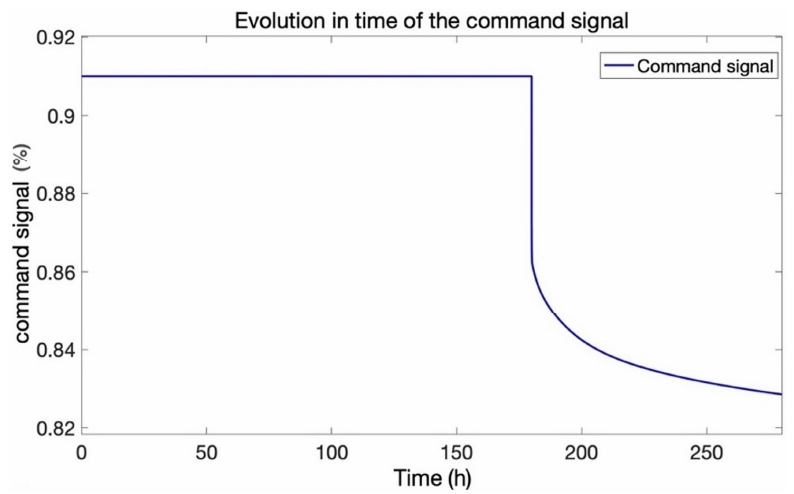
Figure 20. Evolution in time of the control signal applied in order to adapt the proposed model of the separation process when the fractional differentiation order varies from β = 0.91 to β = 0.82 at t = 180 ( h )